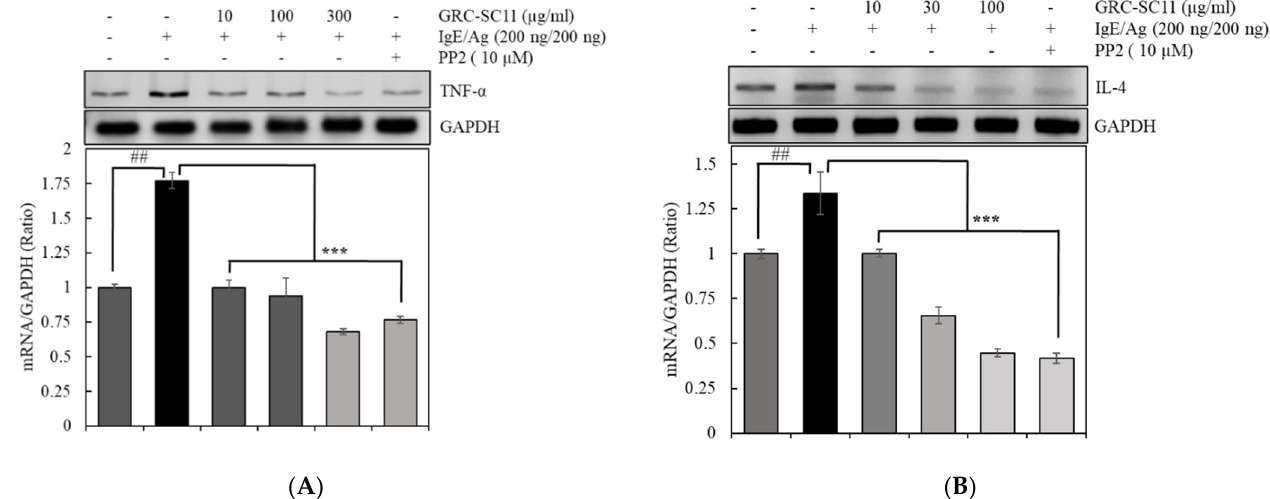
Figure 3. Effect of GRC-SC11 on the production of pro-inflammatory cytokines in IgE/Ag-stimulated RBL-2H3 mast cells. The RBL-2H3 cells were untreated or treated with indicated concentrations of GRC-SC11 in the absence or presence of the 200 ng/mL of IgE/Ag or 10 μ M of PP2. GRC-SC11 reduced the expressions of ( A ) tumor necrosis factor (TNF)- α and ( B ) in- terleukin (IL)-4 in IgE/Ag-stimulated RBL-2H3 mast cells. The expression study was carried out by Western blotting method using GAPDH as the loading control. The relative amounts of TNF- α , IL-4 were analyzed by using the Image J software. The results are presented as the representative or mean ± SD of three independent experiments. Results were analyzed for statistical significance through a one-way ANOVA followed by Dunnett’s t -test. The probability value of ## p < 0.01 was considered significant compared to the non-treated cells and *** p < 0.01 compared to the IgE/Ag-treated